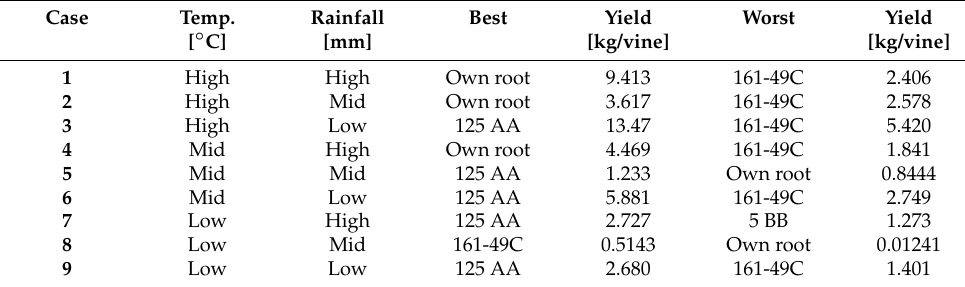
Table 7. Model-based berry yield predictions for tested